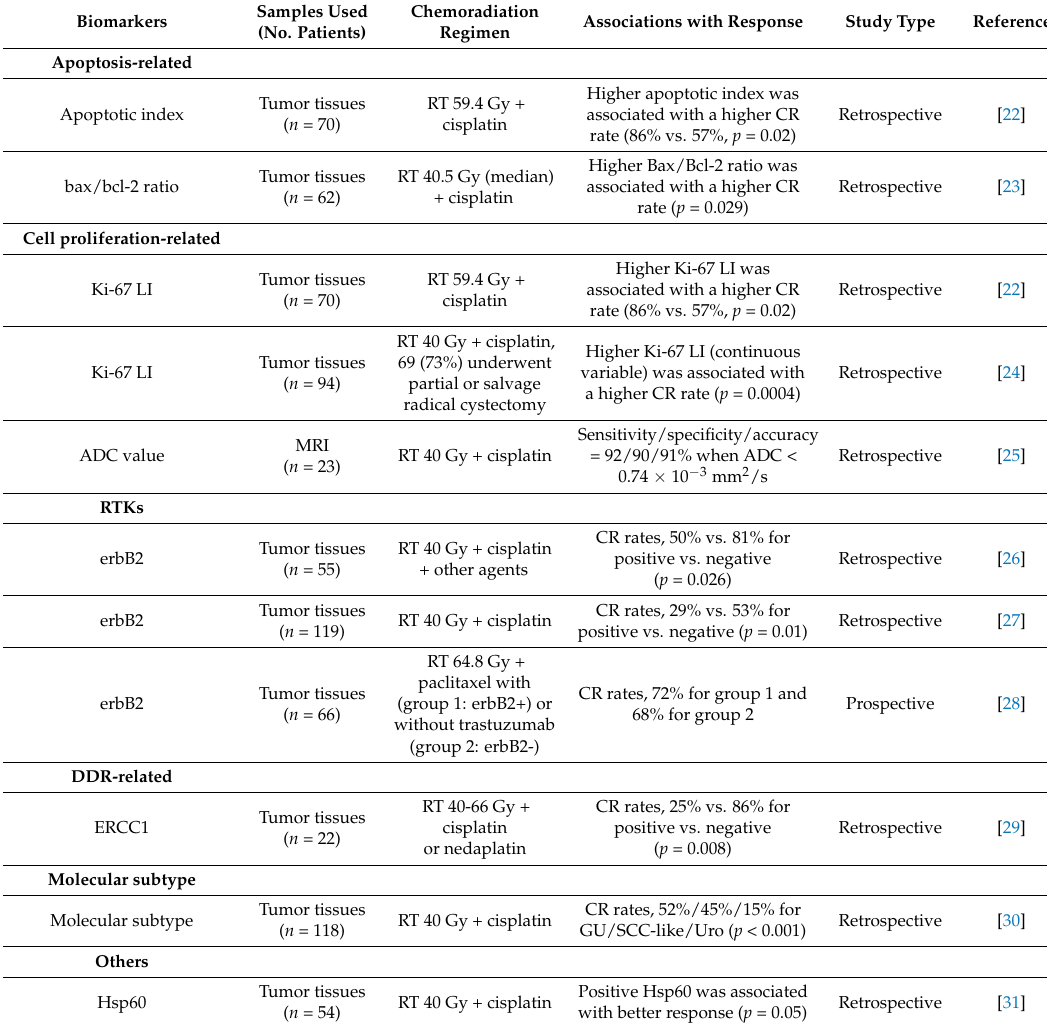
Table 1. Biomarkers associated with chemoradiation